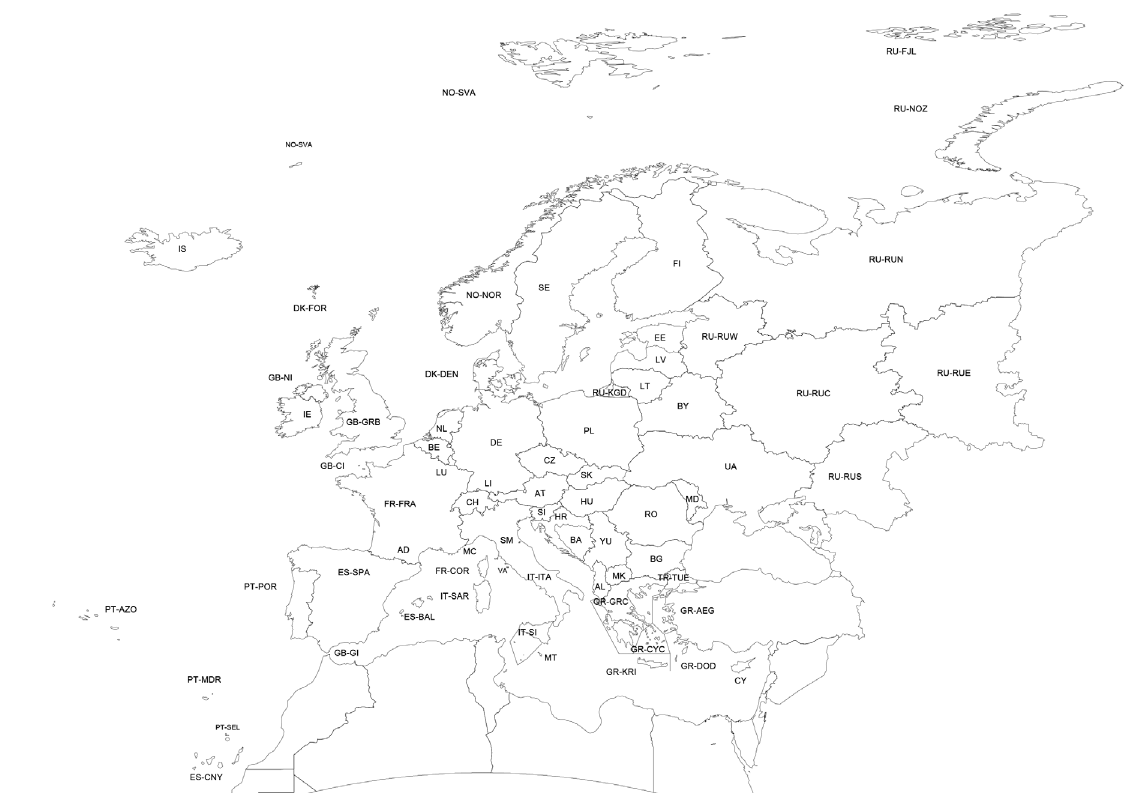
Fig. 5. Area codes as used in the atlas, from Fauna Europaea guidelines (de Jong et al. 2014: supplementary material 1), reproduced with permission. Note that MN (Montenegro) and SB (Serbia) are collectively shown as YU (Yugoslavia) on this map. Also note that CY (Cyprus) is not covered by the